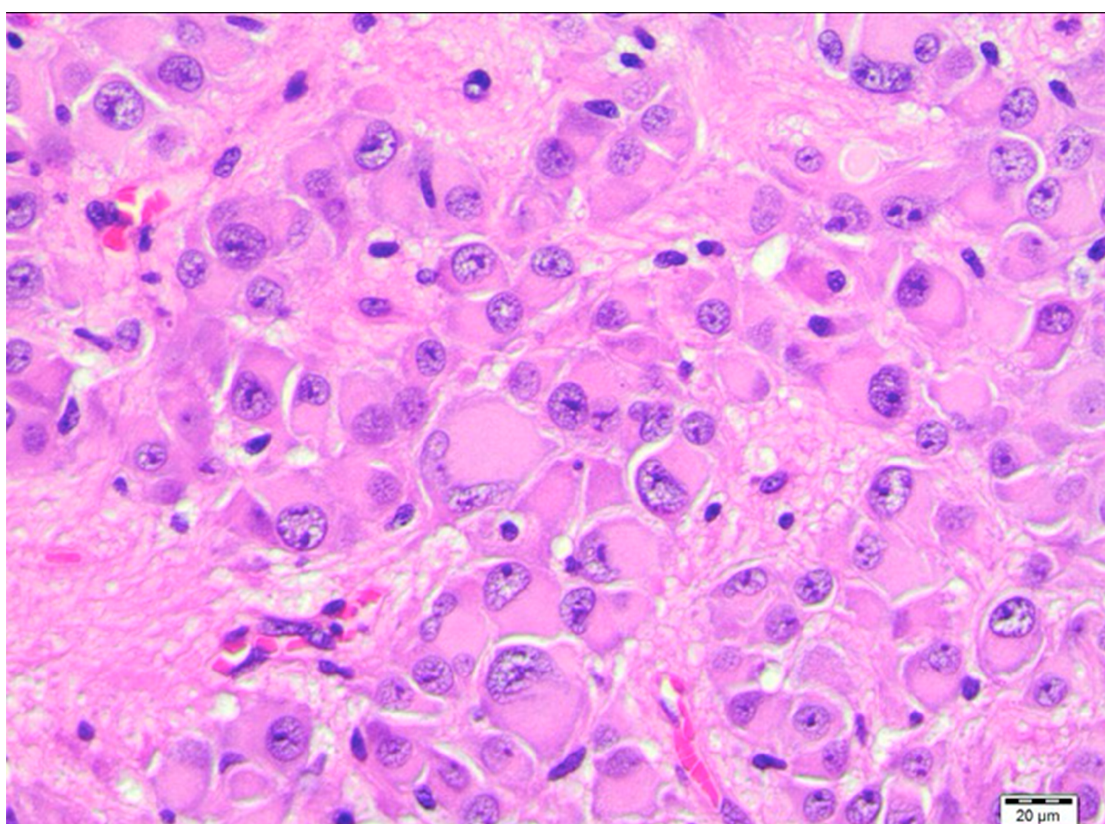
Figure 2. SEGA. Large cells resembling ganglion cells and gemistocytic astrocytes. HE staining. (Courtesy of prof. Wiesława Grajkowska, Pathology Department, The Children’s Memorial Health Institute, Warsaw).